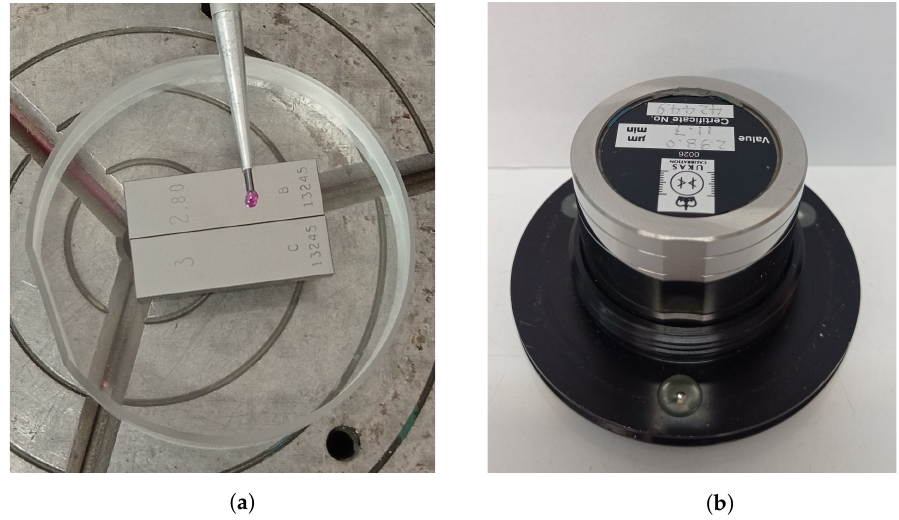
Figure 1. ( a ) Height standard made from two gauge blocks wrung to the optical flat with a visible stylus probe on one of the blocks; ( b ) Flick standard with one surface